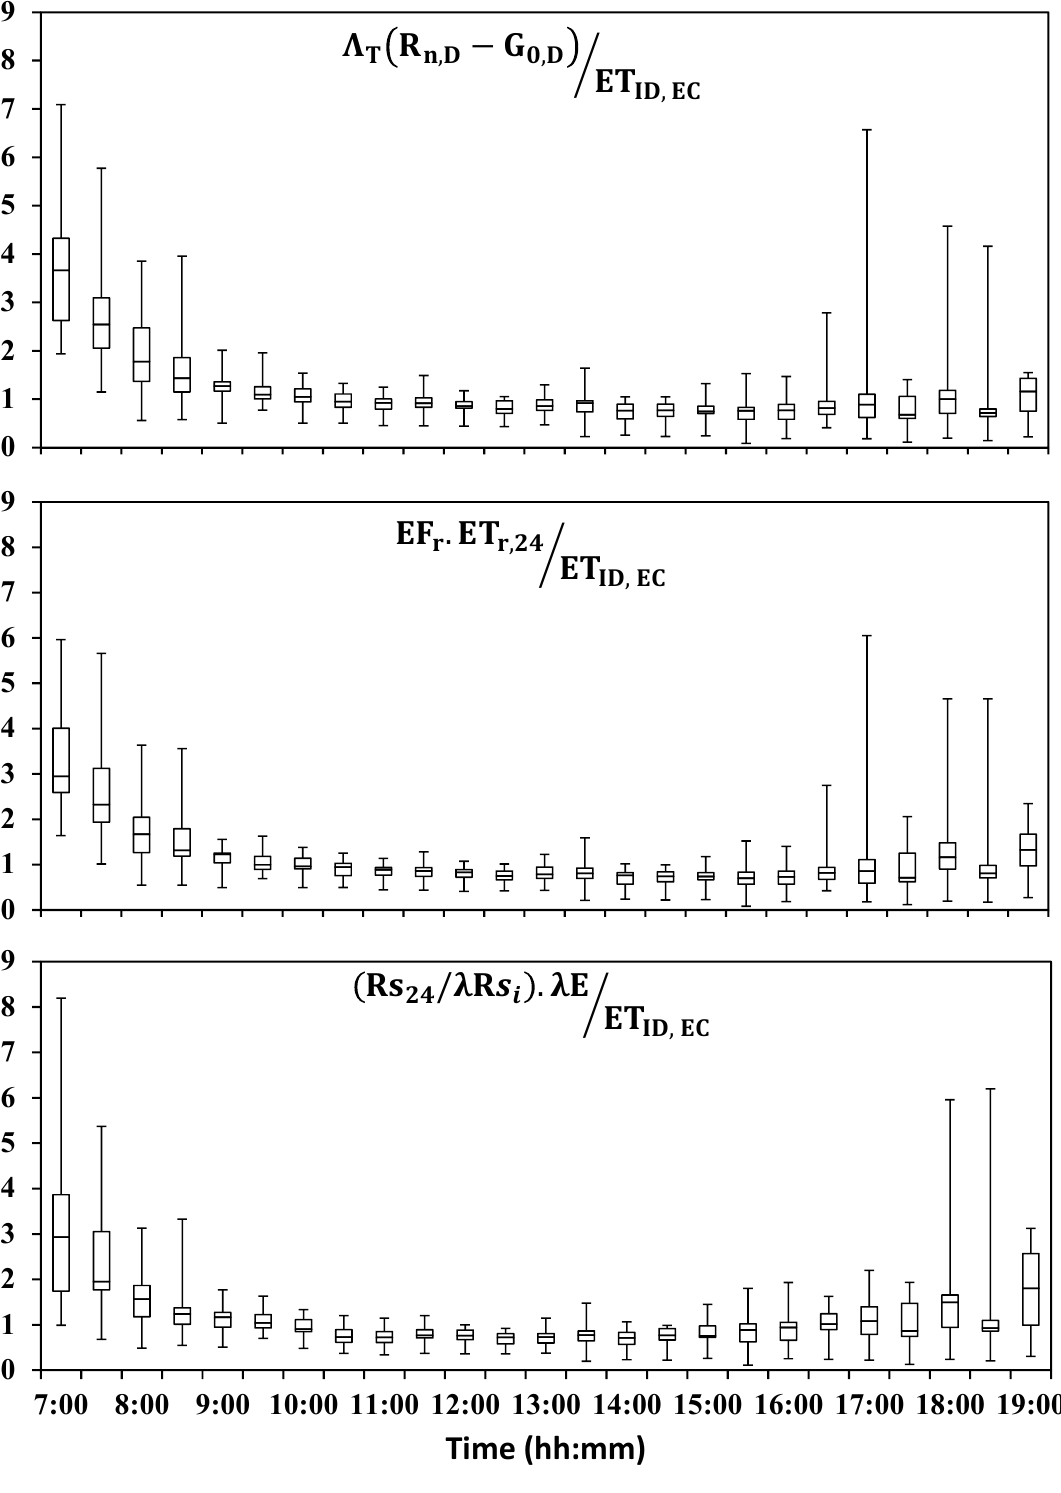
Figure 6. Box and whisker plot for the 30 min temporal variability of the ratio of tower-derived and upscaled ET a,D based on Λ T , ET r and Rs 24 /Rs i to the EC measured daily actual ET (ET ID, EC ). The boxes show first (25th percentile), second (median), and third quartiles (75th percentile), and whiskers represent the minimum and maximum values.